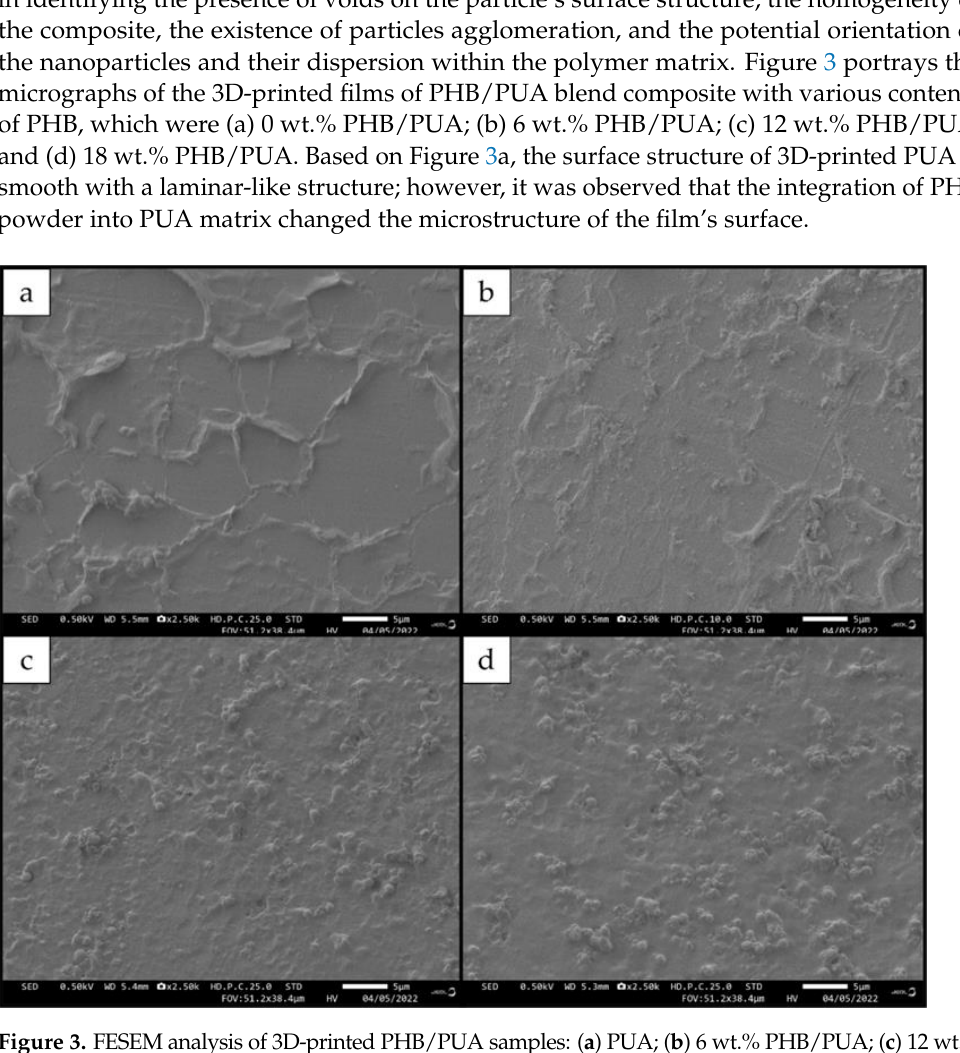
Figure 3. FESEM analysis of 3D-printed PHB/PUA samples: ( a ) PUA; ( b ) 6 wt.% PHB/PUA; ( c ) 12 wt.% PHB/PUA and ( d ) 18 wt.% PHB/PUA.